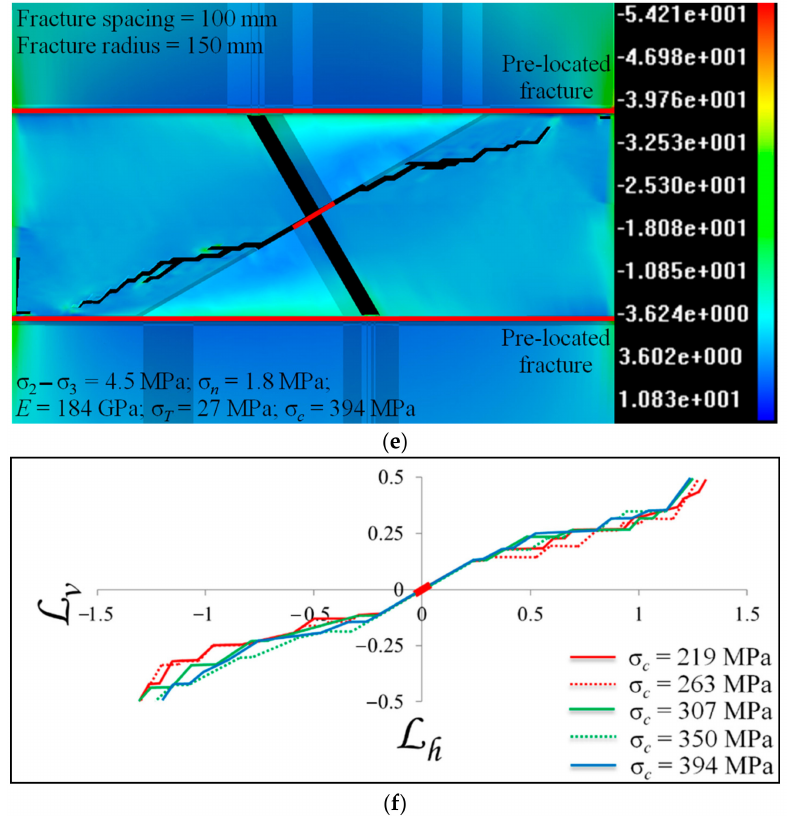
Figure 4. Modelling results of Set 1 in Table 6 [32] (the legends in ( a – e ) show the σ 3 distributions):